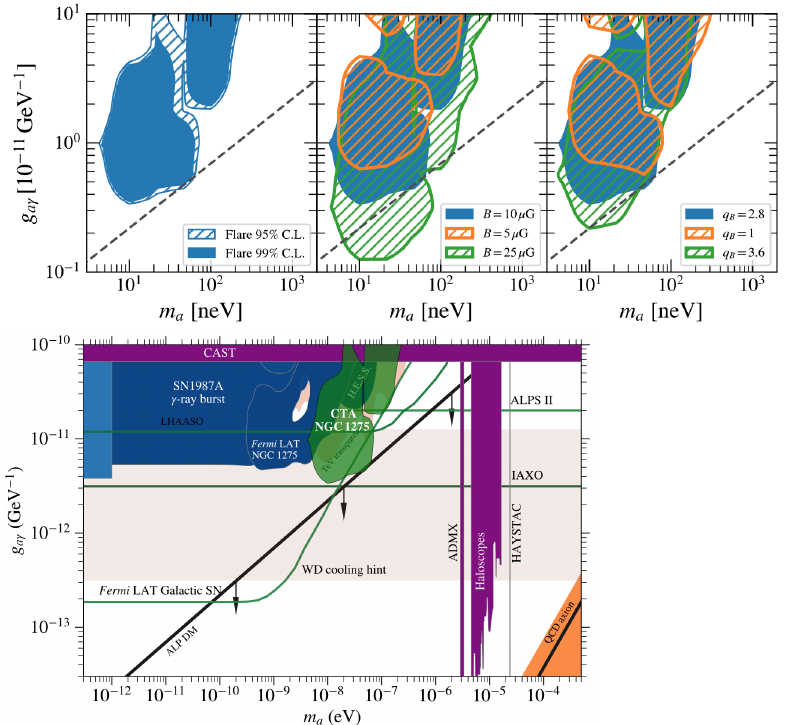
Figure 8. ( Top ) Projected CTA exclusions on the ALPs parameter space for different assumptions on the intracluster magnetic field parameters. Reprinted from Abdalla et al. [45]. ( Bottom ) Projected limits from the CTA simulations, compared to constraints on the ALPs parameter space with Fermi LAT and H.E.S.S. Reprinted from Abdalla et al.